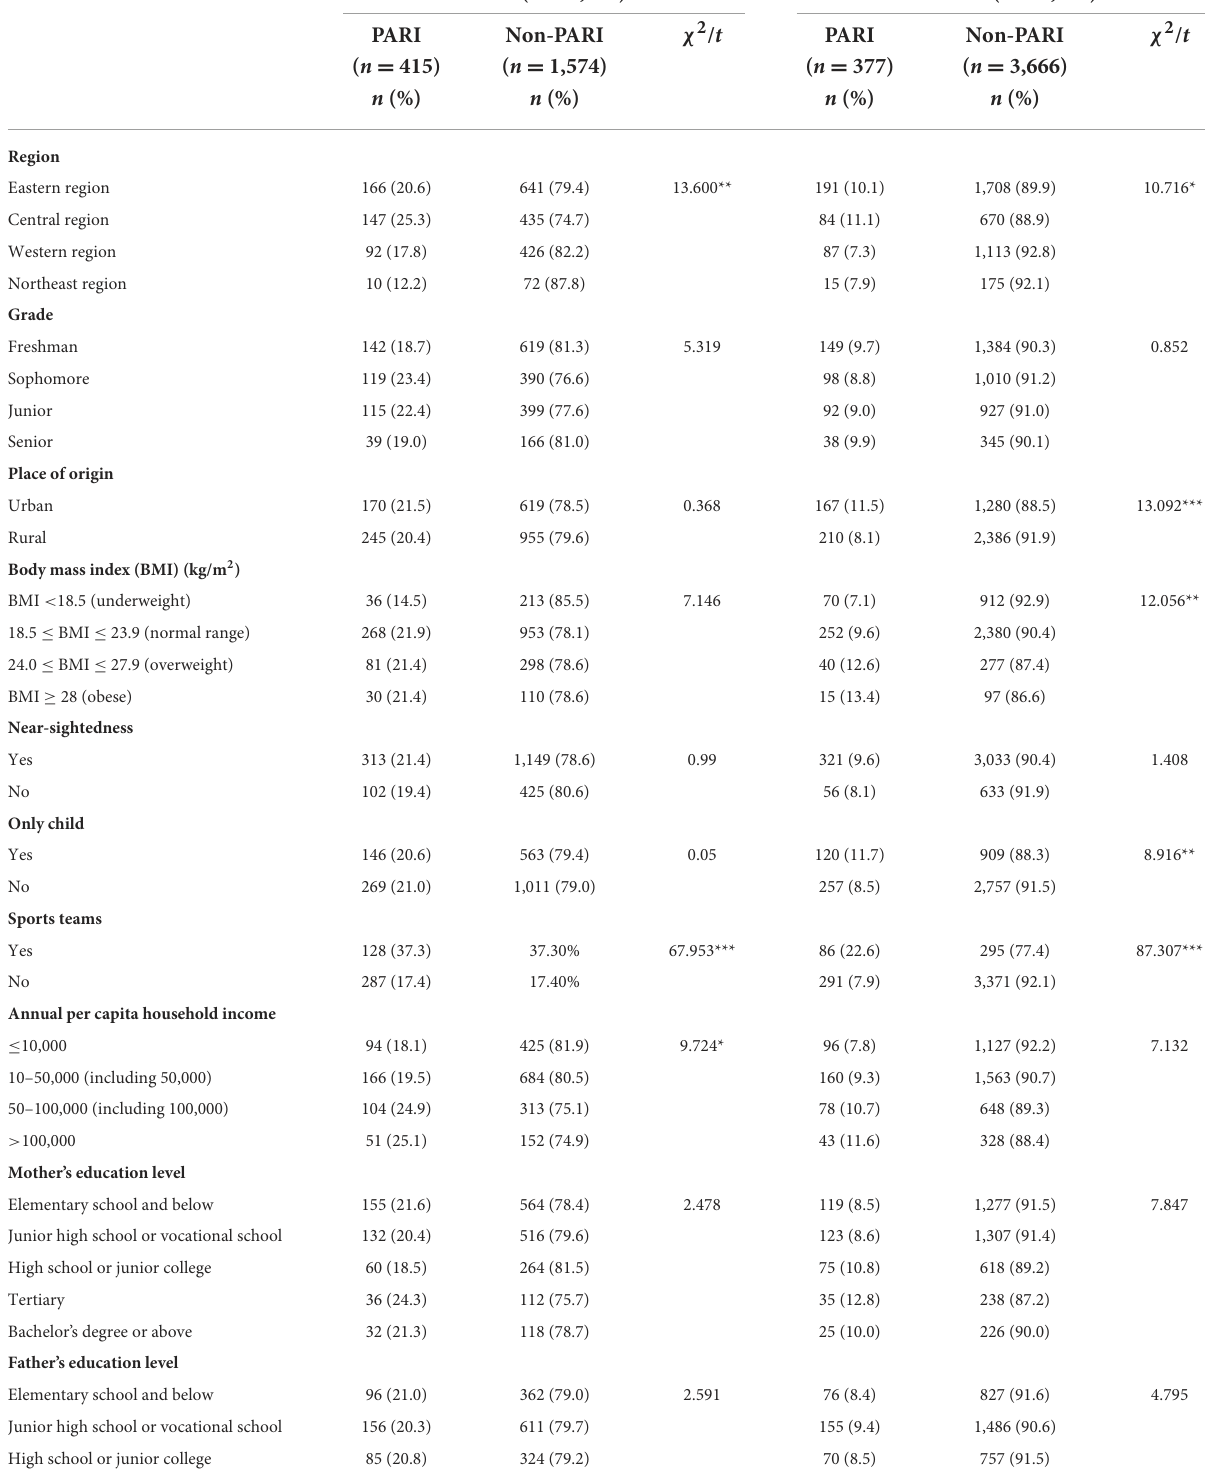
TABLE 1 Sociodemographic contrast of PARI and non-PARI in different sexes of the population.